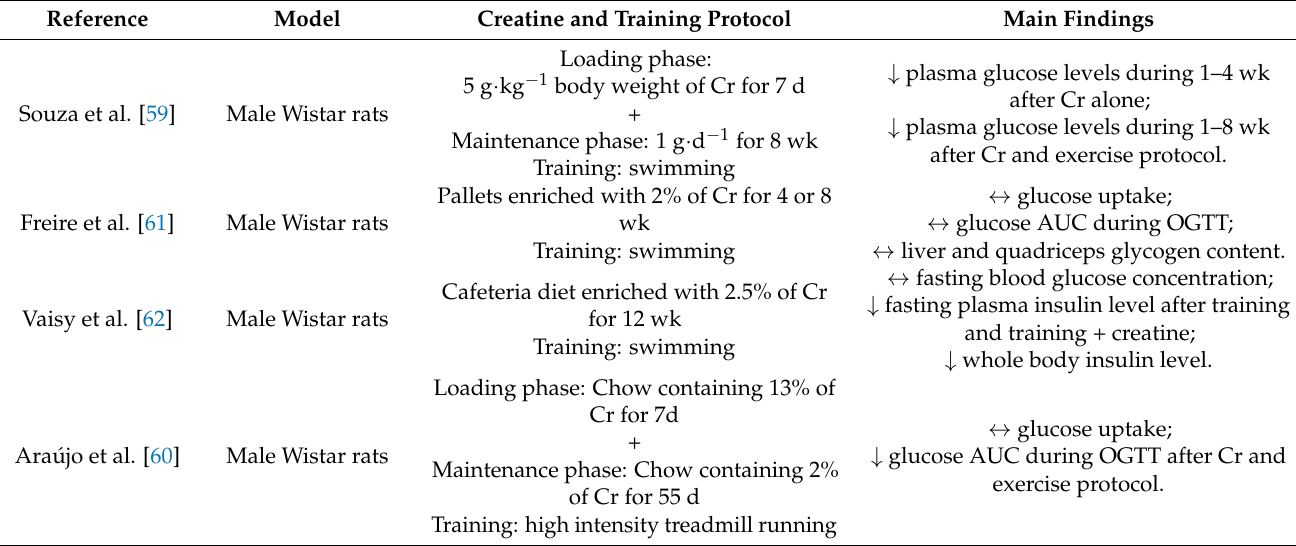
Table 3. Effect of creatine supplementation along with exercise in glucose metabolism in